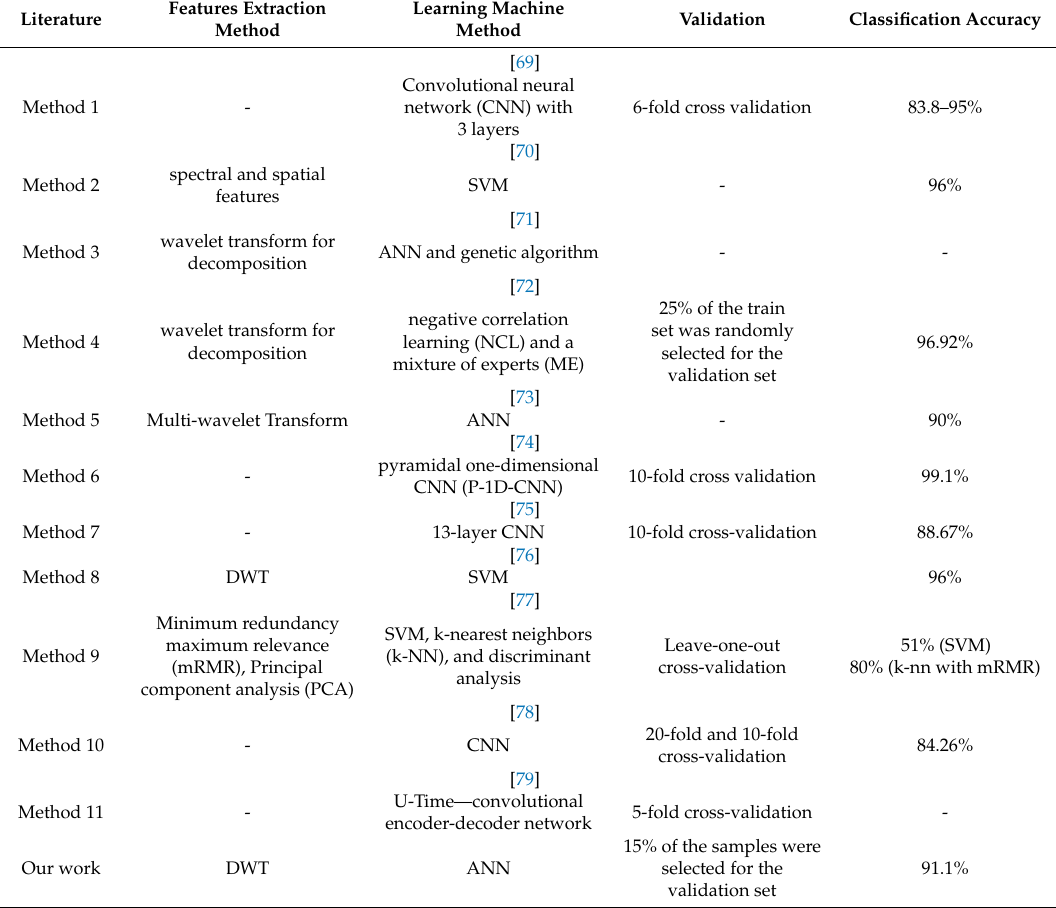
Table 3. Methodology description of recent state-of-the-art compared with our